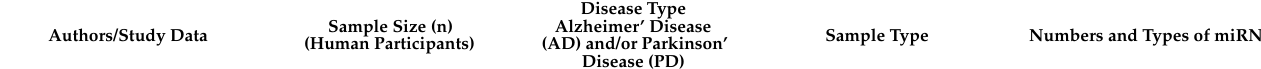
Table 4. Results of the Detection Rate (Accuracy (%) of the identification of miRNAs by qPCR in each selected study. Alzheimer’s disease (AD); Parkinson’s disease